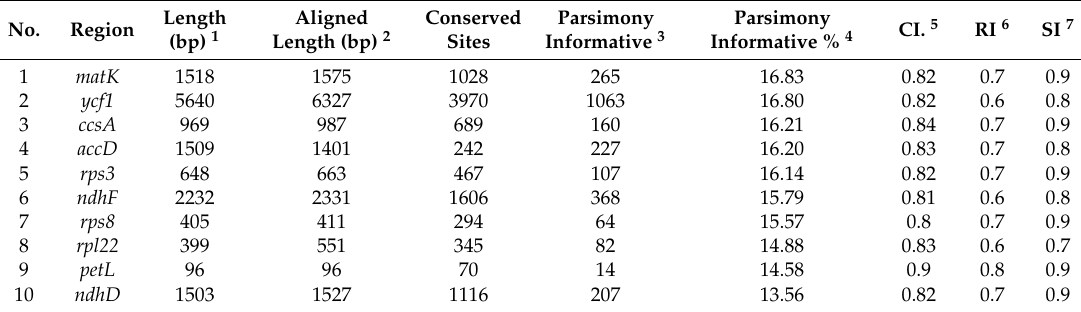
Table 5. Ten highest informative sites of coding genes in eight